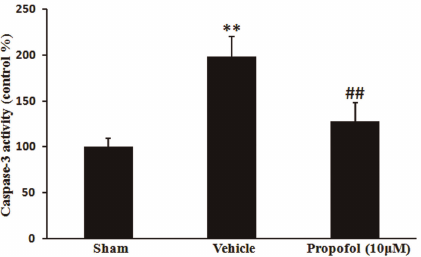
Figure 5. Effect of propofol on burn serum-induced caspase-3 activation. Compared with sham cells, burn serum significantly increased caspase-3 activity. Propofol treatment inhibited the burn serum-induced increase in caspase-3 activity. Data are reported as means±SD (n=5 in each group). **P , 0.01, compared to the sham group; ## P , 0.01 compared to the vehicle group (one-way